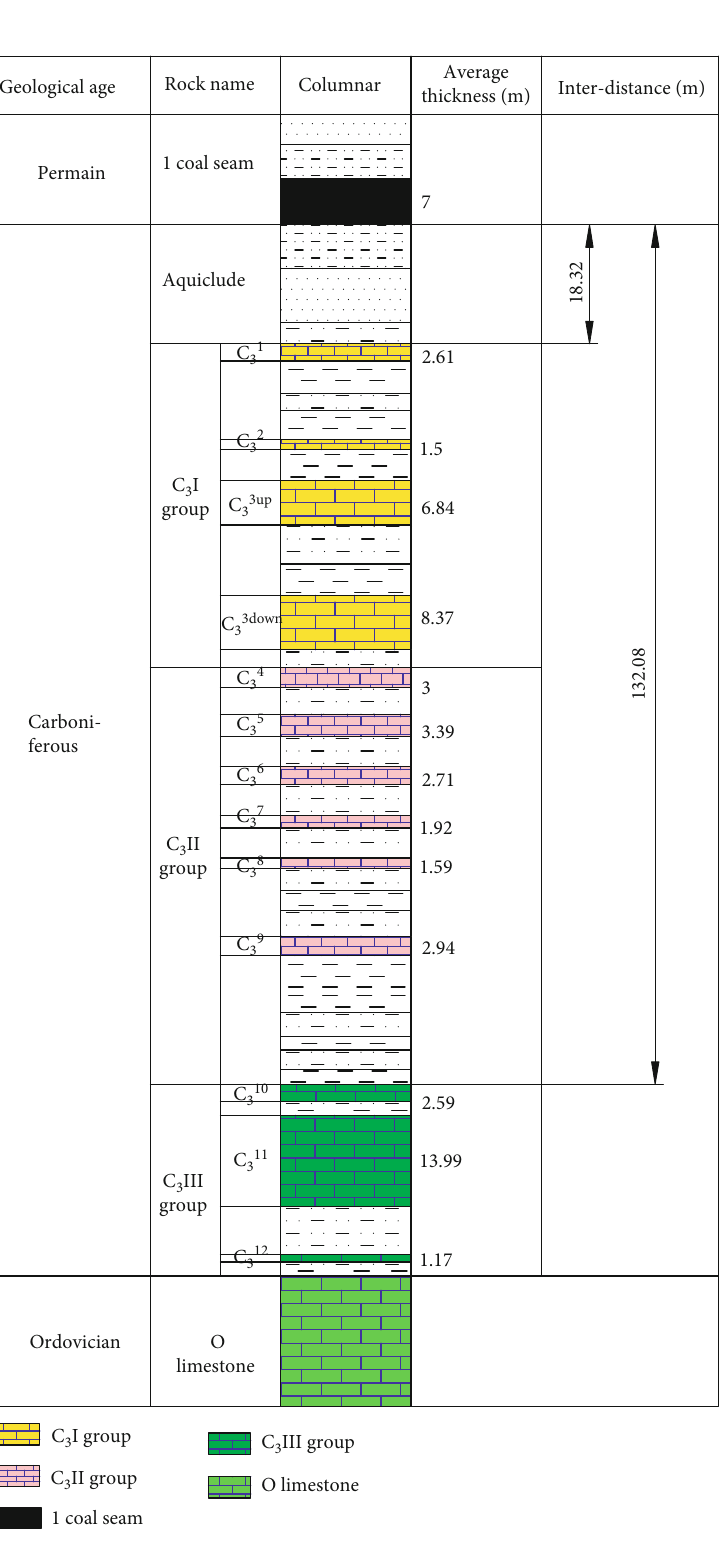
Figure 4: The comprehensive columnar of the mining